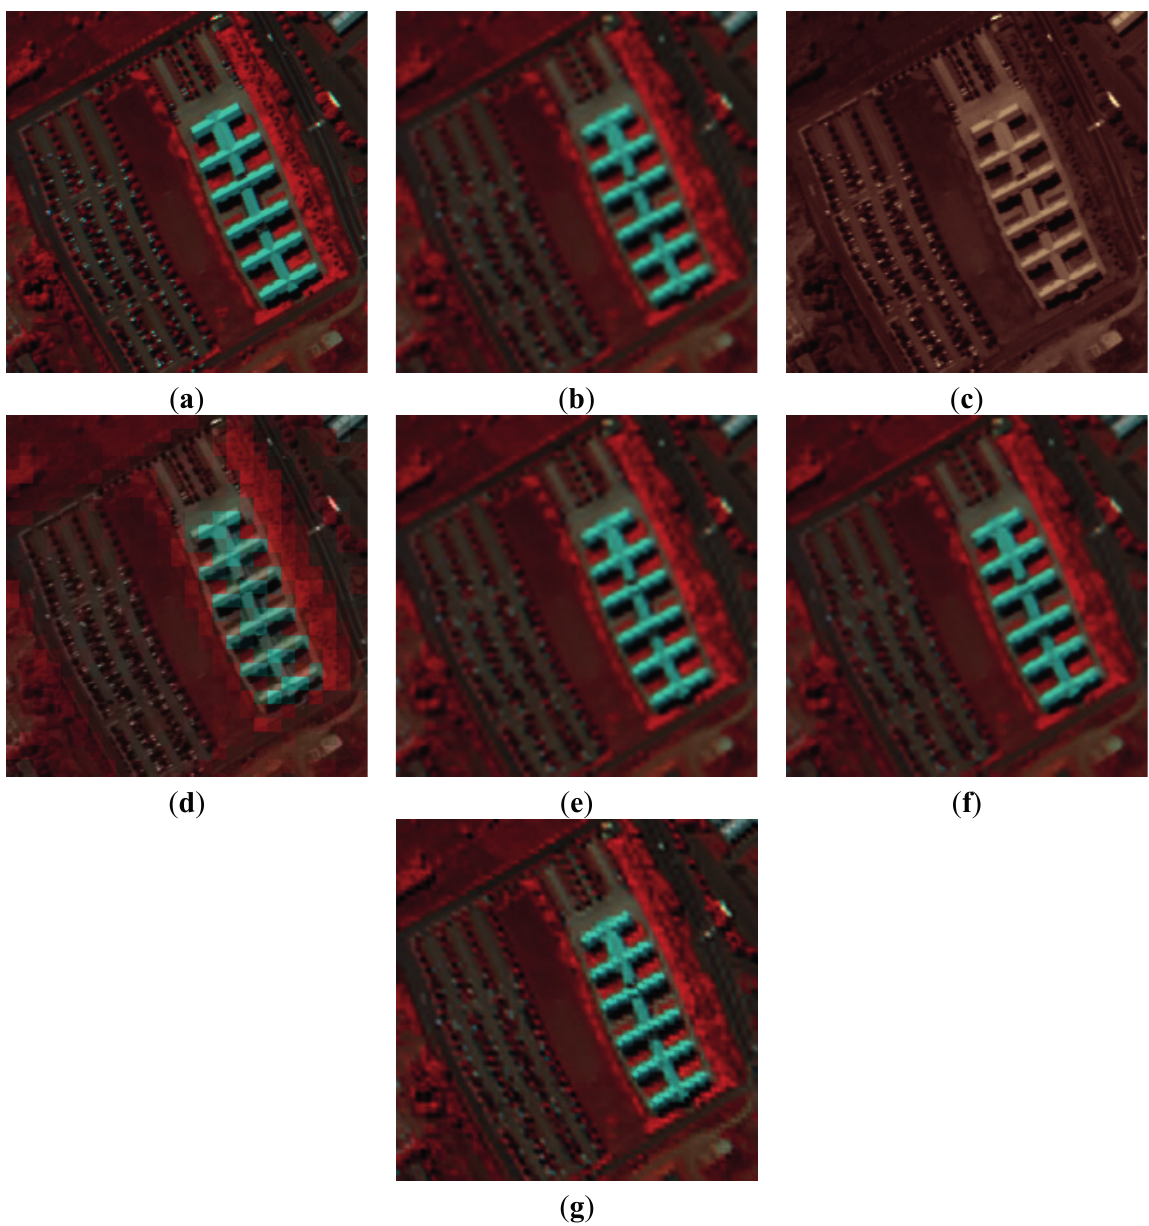
Figure 4. Experimental results of PaviaU HSI (color composite of R: 80, G: 28, B: 9). ( a ) the false color image of original HSI; ( b ) bicubic interpolation; ( c ) PCA fusion method; ( d ) WT fusion method; ( e ) P + XS fusion method; ( f ) SR-SR method; ( g ) the proposed